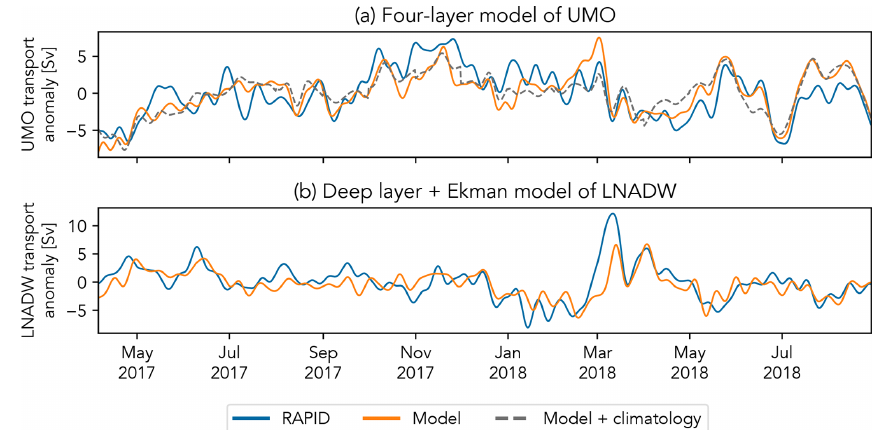
Figure 4. (a) UMO transport anomaly estimated from the most recent RAPID observations (blue) compared to the UMO transport anomaly predicted by the four-layer regression model (orange) using density anomalies derived from the same RAPID data. The RAPID data were 12-hourly and 10d filtered. The dashed grey line shows the model prediction where the eastern boundary density anomaly at 980dbar is replaced by a monthly climatology. (b) LNADW transport anomaly estimated from the most recent RAPID observations (blue) compared to the LNADW transport anomaly predicted by the regression model combining the western boundary density anomaly at 3040dbar (orange) derived from the same RAPID data and the Ekman